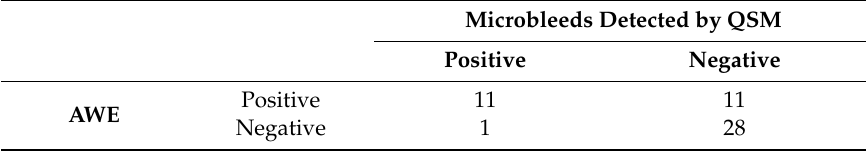
Table 3. Relationship between the visualization of microbleeds detected by QSM and aneurysm wall enhancement.